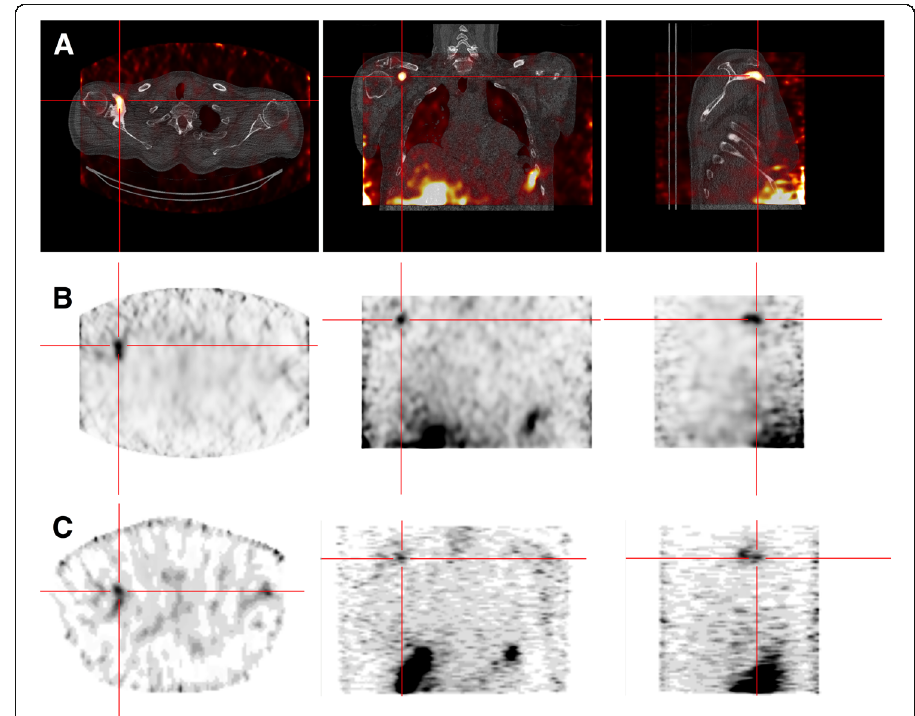
Fig. 6 SPECT imaging of 30-min duration performed successively on CzT (with ( a ) and without ( b ) CT image fusion) and Anger cameras ( c ) 48-h after intravenous injection of 5.27 MBq of 223 Ra. An uptake on a right shoulder bone metastasis was visible on axial, coronal and sagittal slices (left to